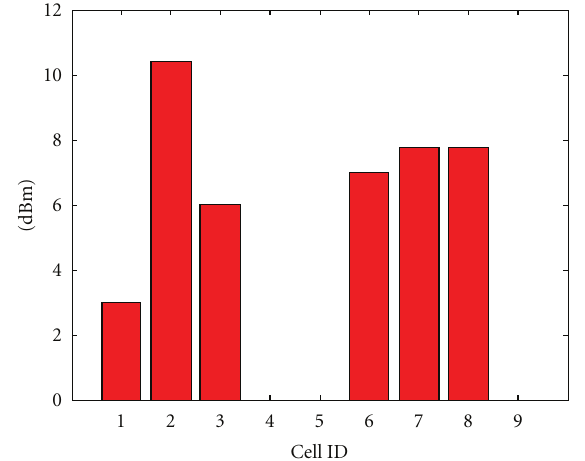
Figure 20: Optimal pilot power given by exhaustive search (no. of FBSs = 5).